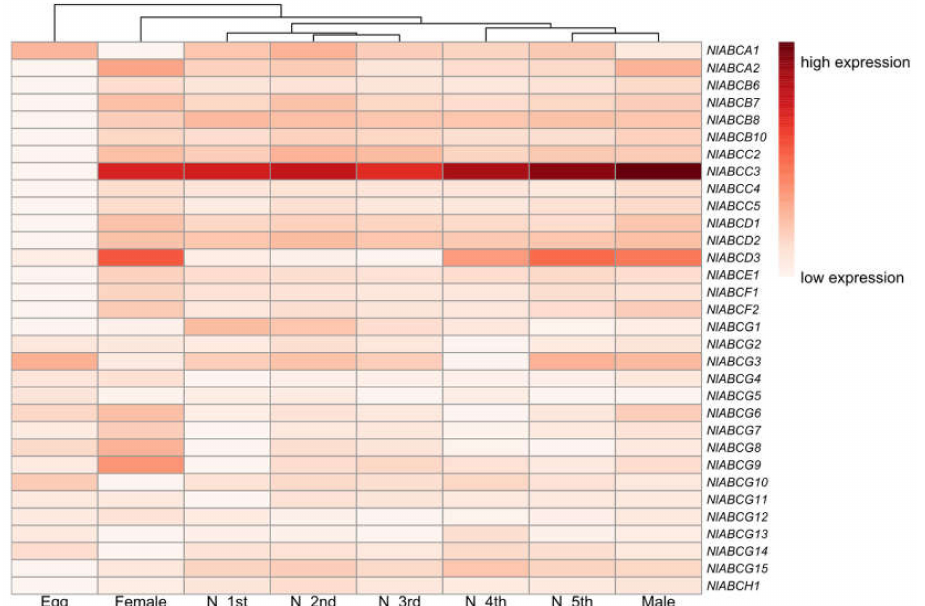
Figure 2. Relative expression levels of ABC transporters at di ff erent developmental stages in the N. lugens life cycle, as determined by qRT-PCR. Letters on the right are the gene names for the 32 ABC transporters. Developmental stages are given at the bottom. The mRNA levels, represented by normalized log10 ( ∆ CT) values, are shown in the gradient heatmap. The color from light to dark indicates the expression level from low to